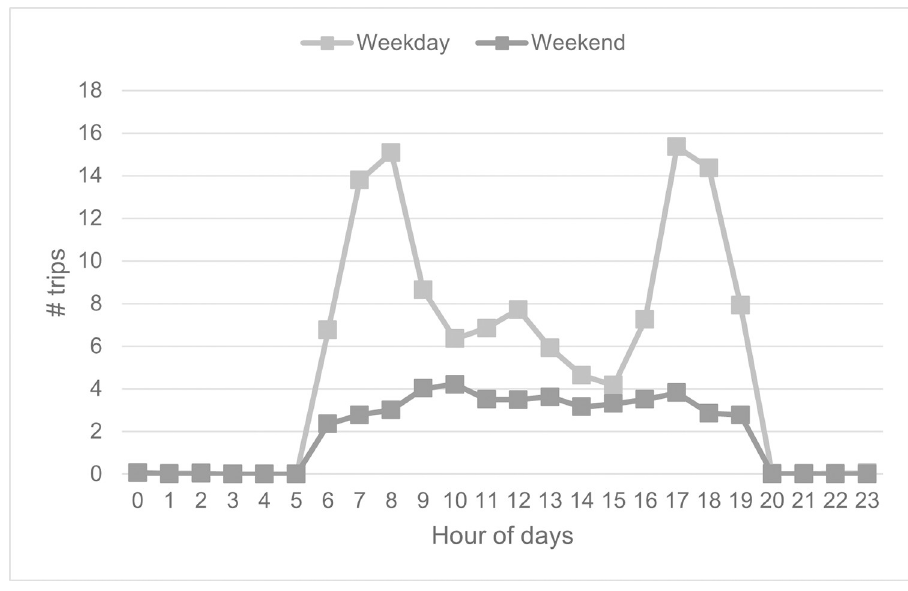
Fig 6. Average number of trips on weekdays and weekends.